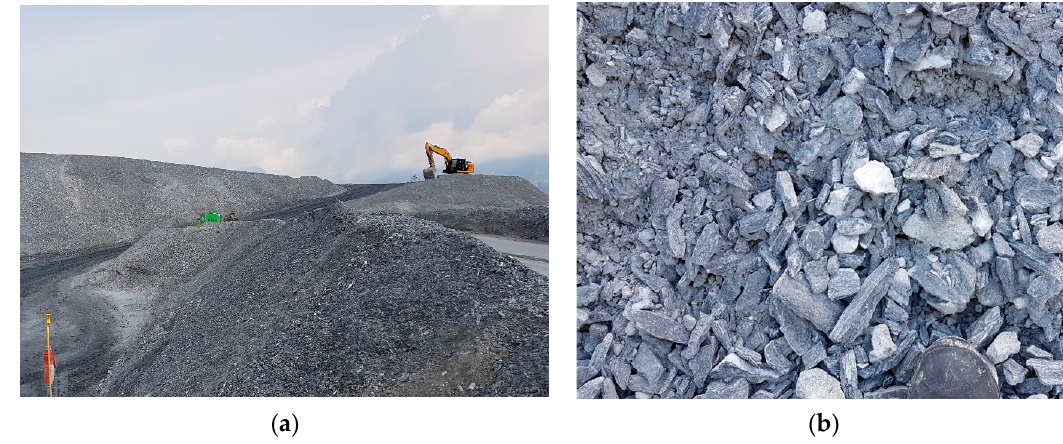
Figure 2. (a) View from the Ahrental landfill with tunnel boring machine material from Bündner Schist rocks; (b) Detailed view of the excavation material from Figure 2a (fines washed out by rain at the surface).